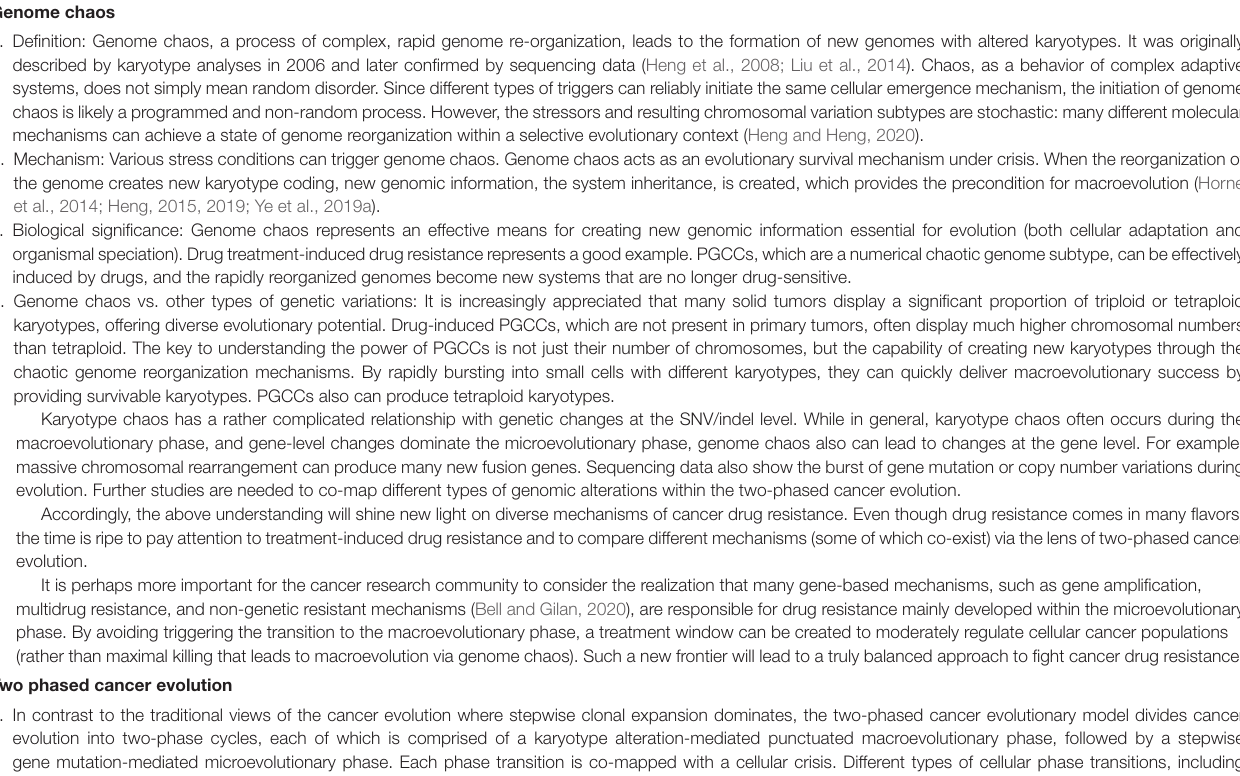
TABLE 1 | Explanations of key concepts, terminologies, and original observations. Genome